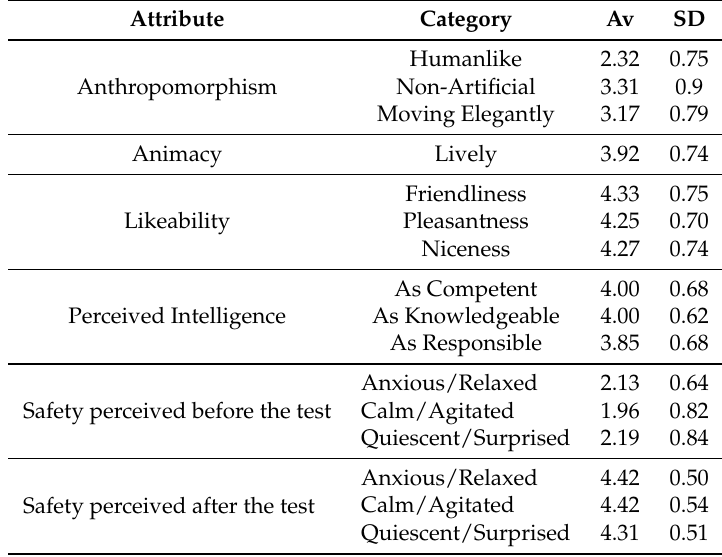
Table 2. The table presents the average (Av) and the standard deviation (SD) of the variables taken into account in the survey tested